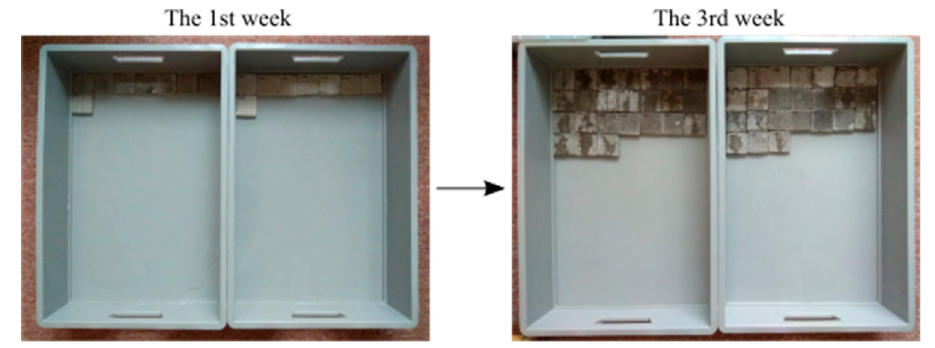
Figure 6. Specimens in tanks during the second phase.